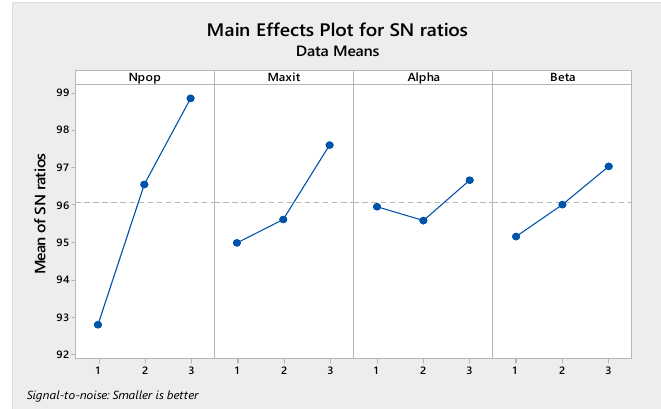
Figure 17. Signal to noise plot of MORSO.